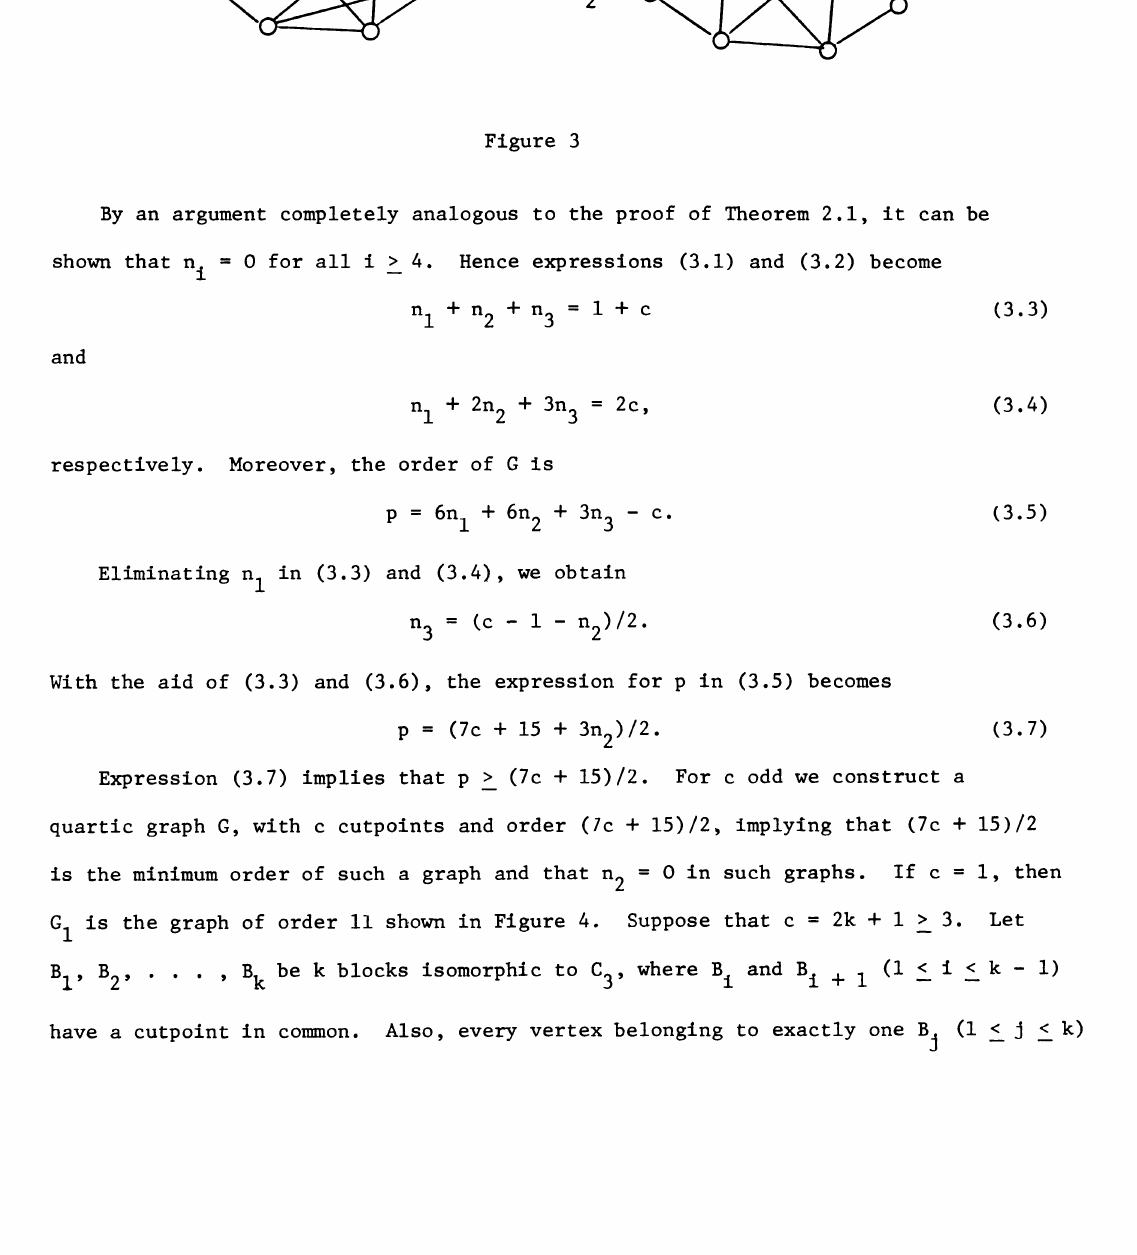
Every end-block of G is necessarily isomorphic to the block E every block of G containing exactly two cutpoints is isomorphic to the block E Figure 3. Note that each of E containing exactly i cutpolnts (i > 3) is isomorphic to the cycle C